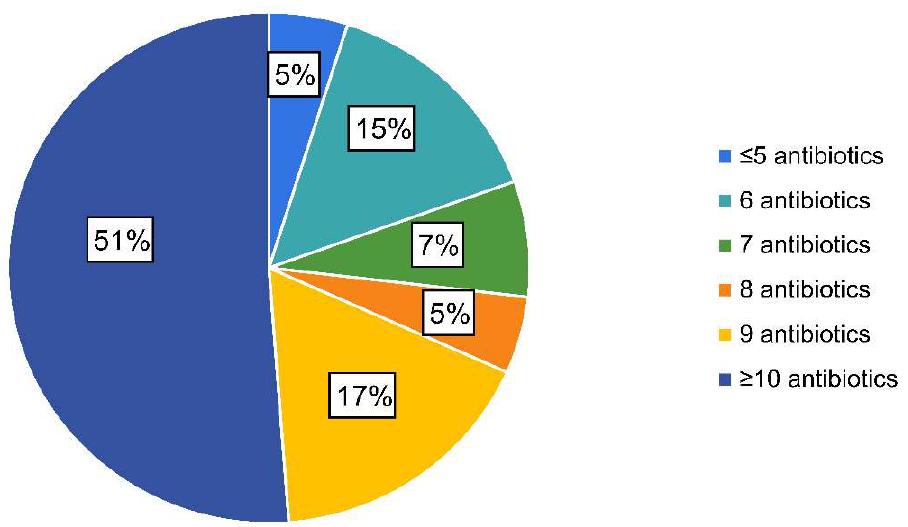
Figure 1. Percentage of enterotoxigenic Escherichia coli isolates considering the number of antimicro- bial resistances per isolate.